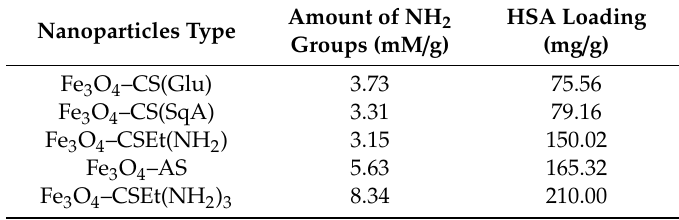
Table 2. Amount of primary amino groups on the MNPs surface and HSA loading (mg/g).